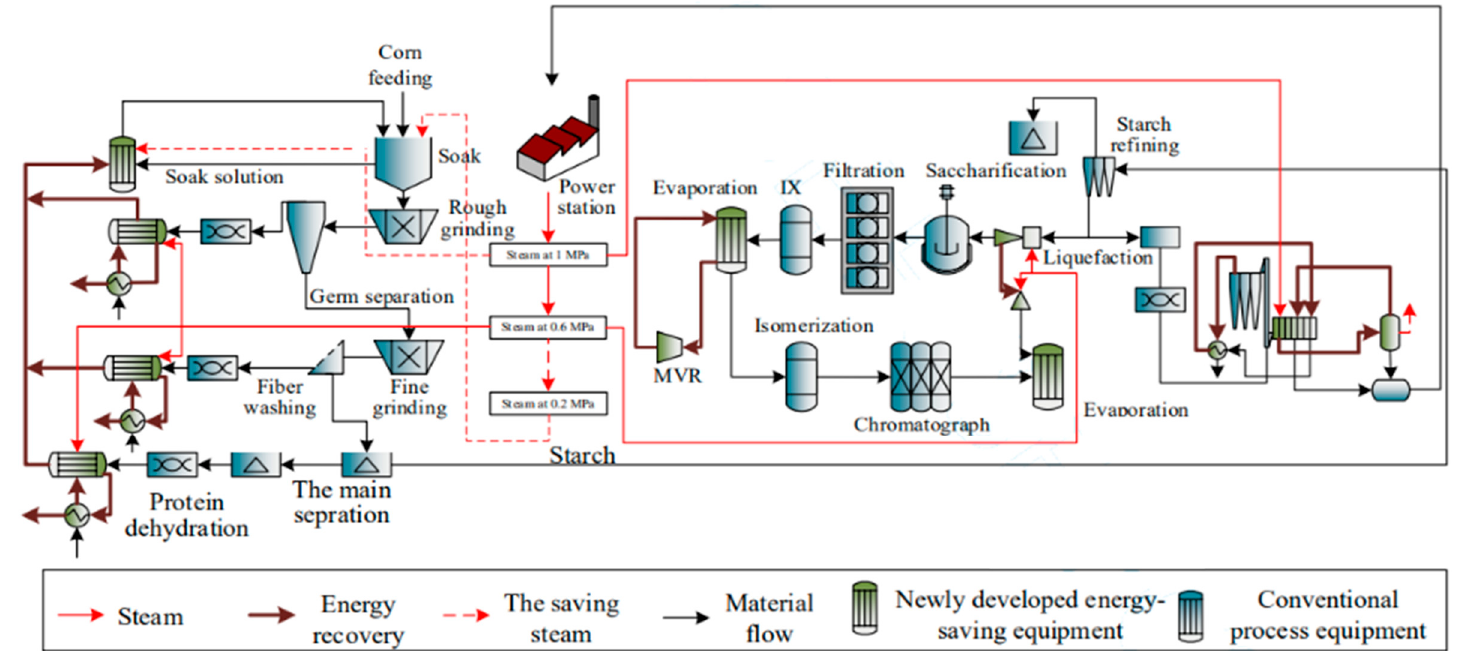
Figure 6. Flow chart of corn-to-sugar process.